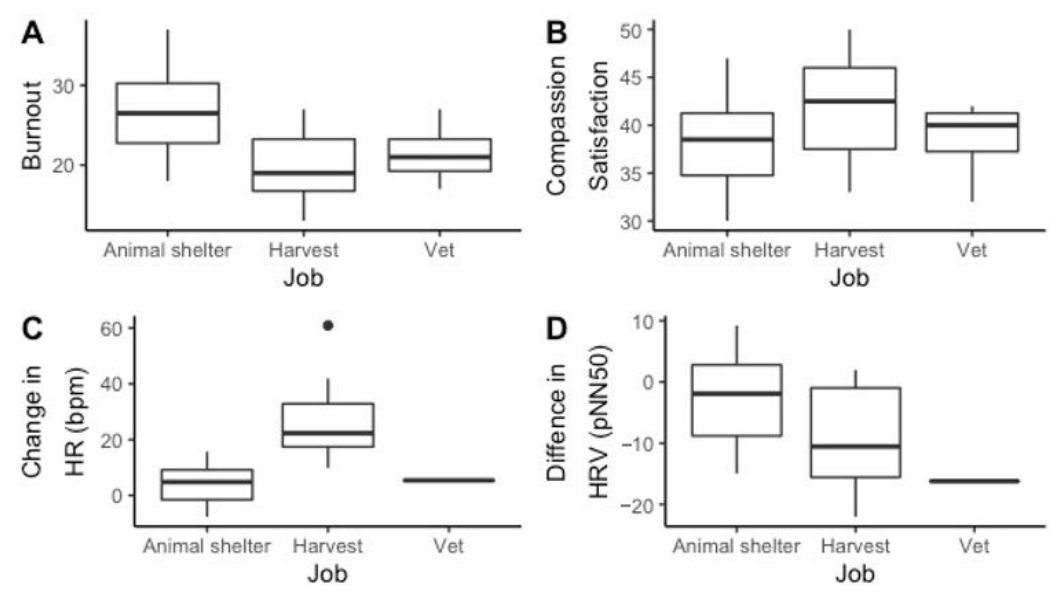
Figure 3. The significant di ff erences in Burnout ( A ), Compassion Satisfaction ( B ), Change in HR ( C ), and Di ff erence in HRV ( D ) by job. Possible burnout and compassion satisfaction scores range from 10 to 50 points. Animal shelter employees had significantly higher burnout (F (2) = 7.246, p = 0.004), lower compassion satisfaction (F (2) = 3.918, p = 0.035), and less change in HR (F (2) = 12.535, p < 0.001), and less di ff erence in HRV (F (2) = 3.842, p = 0.042). HR: heart rate. Int. J. Environ. Res. Public Health 2020 , 17 , x